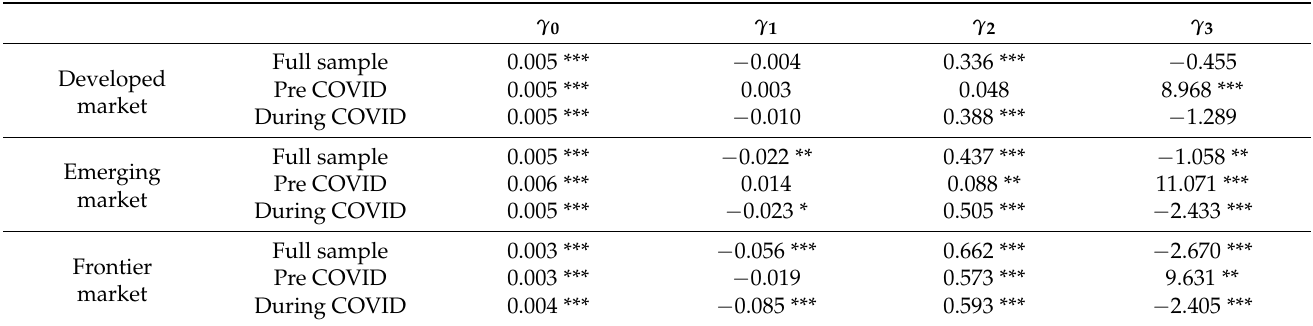
Table 2. Estimates of herding